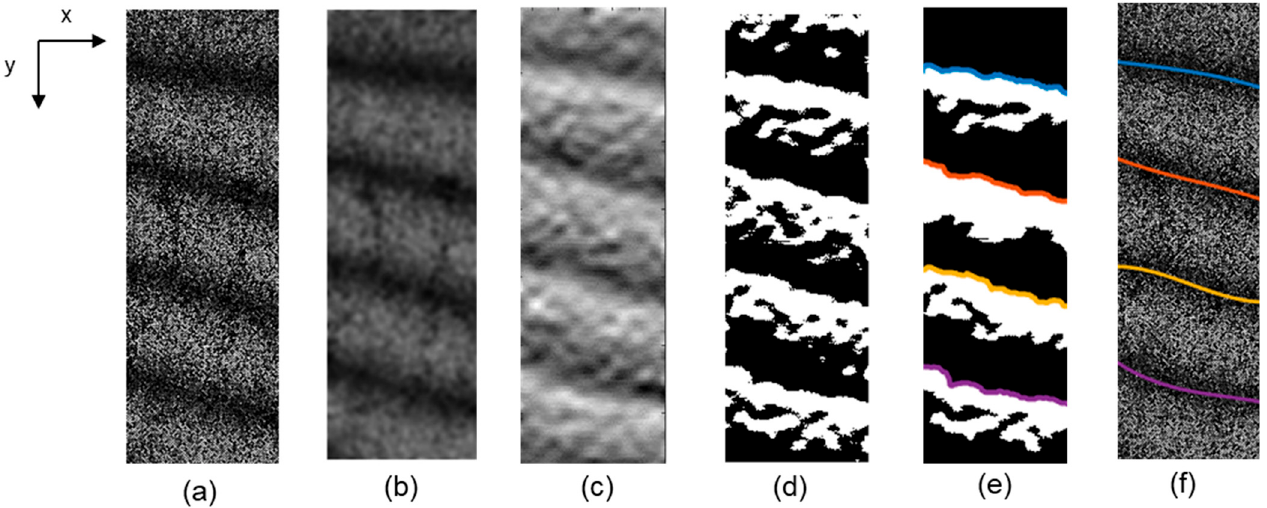
Figure 2. ( a ) original image ( b ) Gaussian filtered image ( c ) partial differential image ( d ) binarized image ( e ) morphology processed image ( f ) detected fringe line.